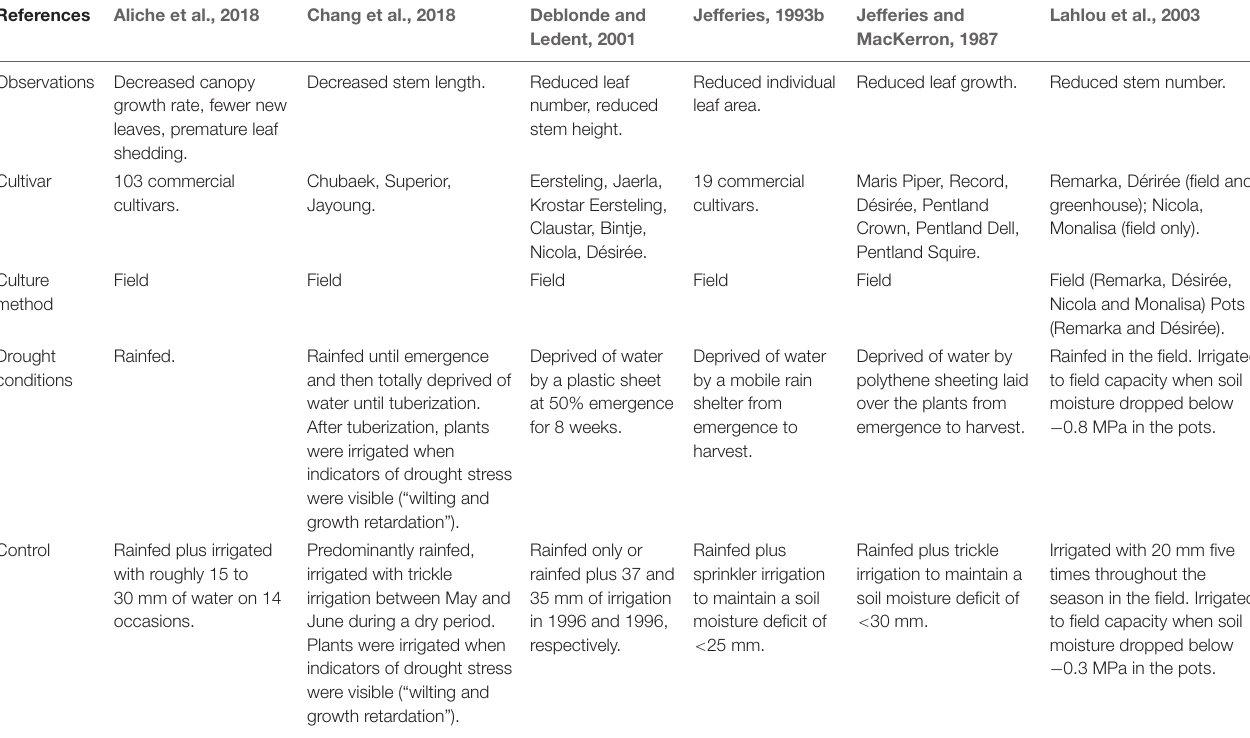
TABLE 2 | A summary of the effects of drought stress on key physiological canopy traits in potato and the range of methodologies by which these variables were